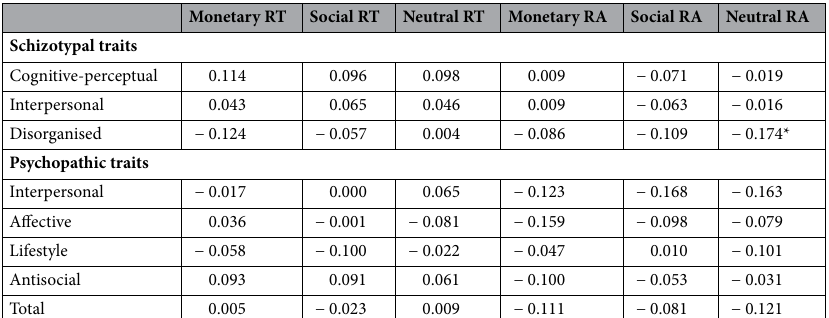
Table 2. Correlations between MSIDT performance and schizotypy and psychopathy dimensions. RT reaction time, RA response accuracy. *Significant at p = 0.05.